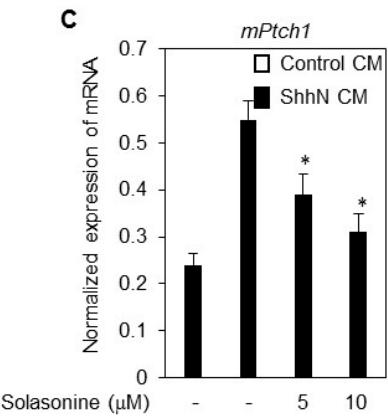
Figure 2. Solasonine inhibits Hh pathway activity in C3H10T1/2 cells. ( A ) Solasonine suppressed the ALP activity in response to ShhN CM in C3H10T1/2 cells. Data are expressed as mean ± s.d.; ( B , C ) Solasonine inhibited the mRNA expression of Gli1 ( B ) and Ptch1 ( C ) provoked by ShhN CM in C3H10T1/2 cells. After treated for 36 h with ShhN CM with or without distinct concentrations of solasonine, C3H10T1/2 cells were harvested for qRT-PCR analysis. Results are expressed as mean ± s.d. ( n = 3). Statistical differences were analyzed by the two-tailed Student ′ s t test and p < 0.05 was considered as significant (* p < 0.05; ** p < 0.01).